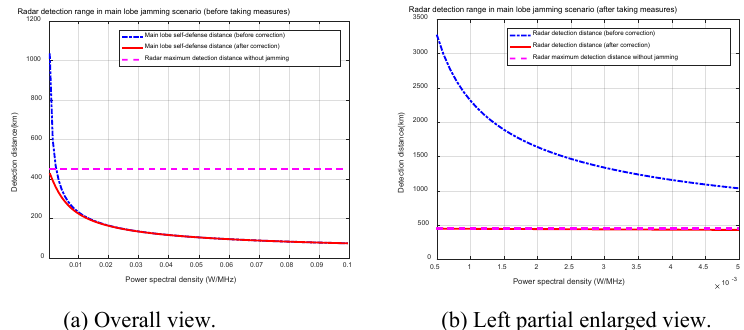
Fig. 2. Comparison of radar mainlobe self-defense distance